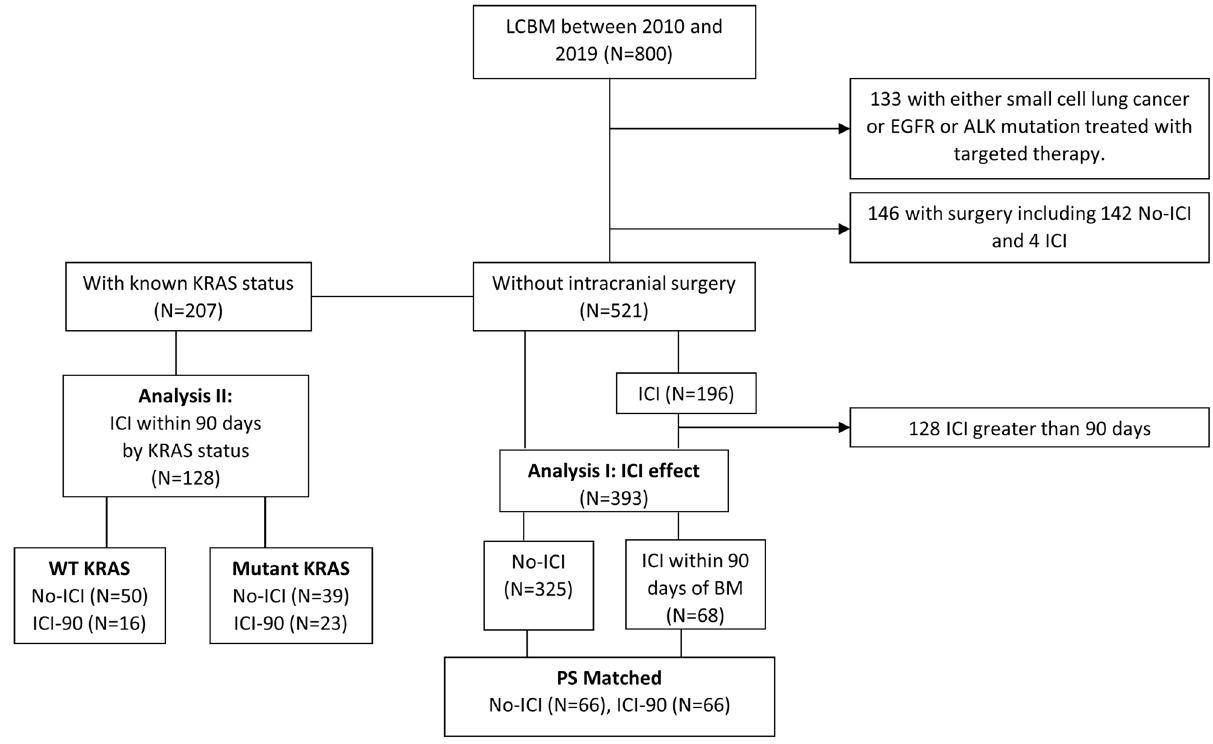
Figure 1. Flow chart of the study population. ICI = immune checkpoint inhibitor; BM = Brain Metastases; LCBM = lung cancer brain